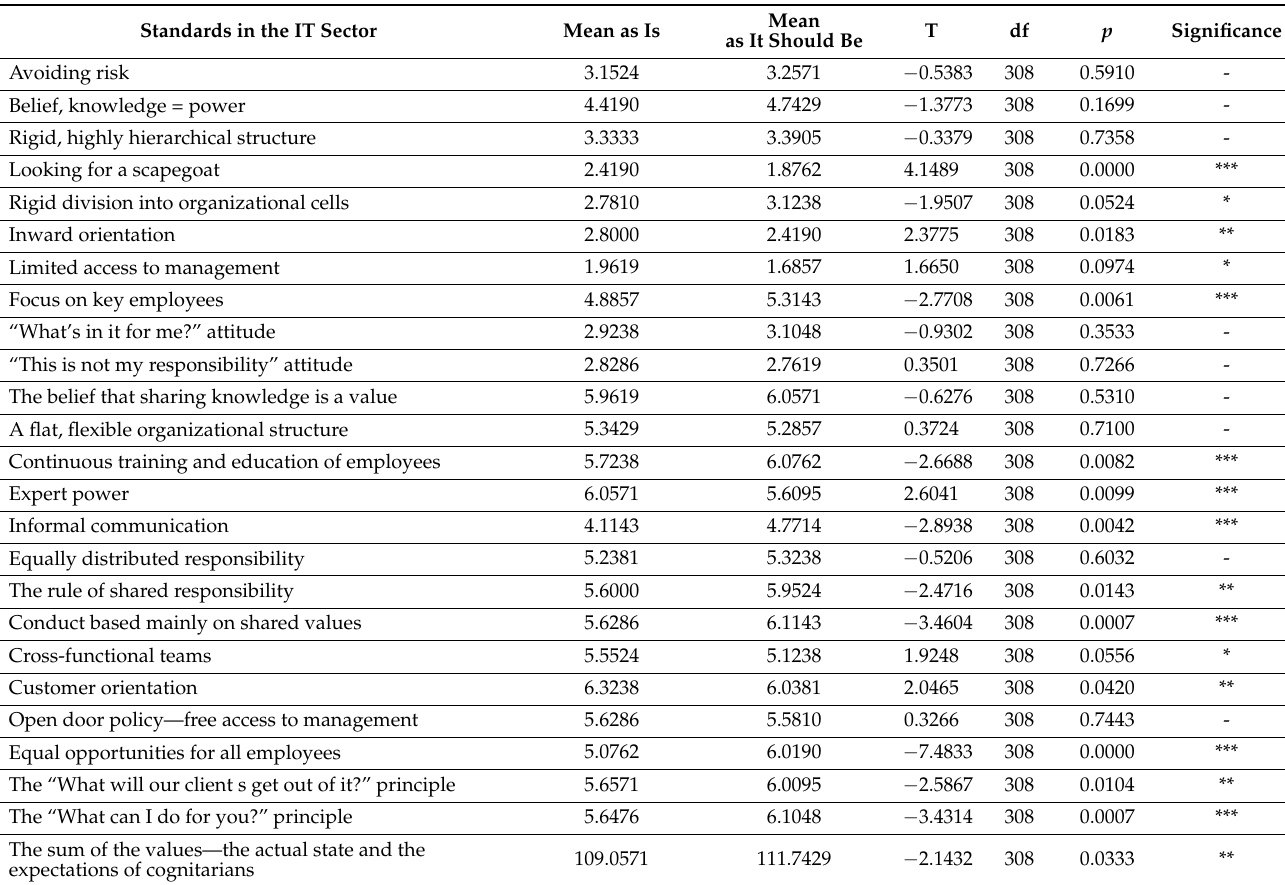
Table 9. T -test for comparing the standards in force in energy companies aimed at knowledge transfer of and individual preferences of IT